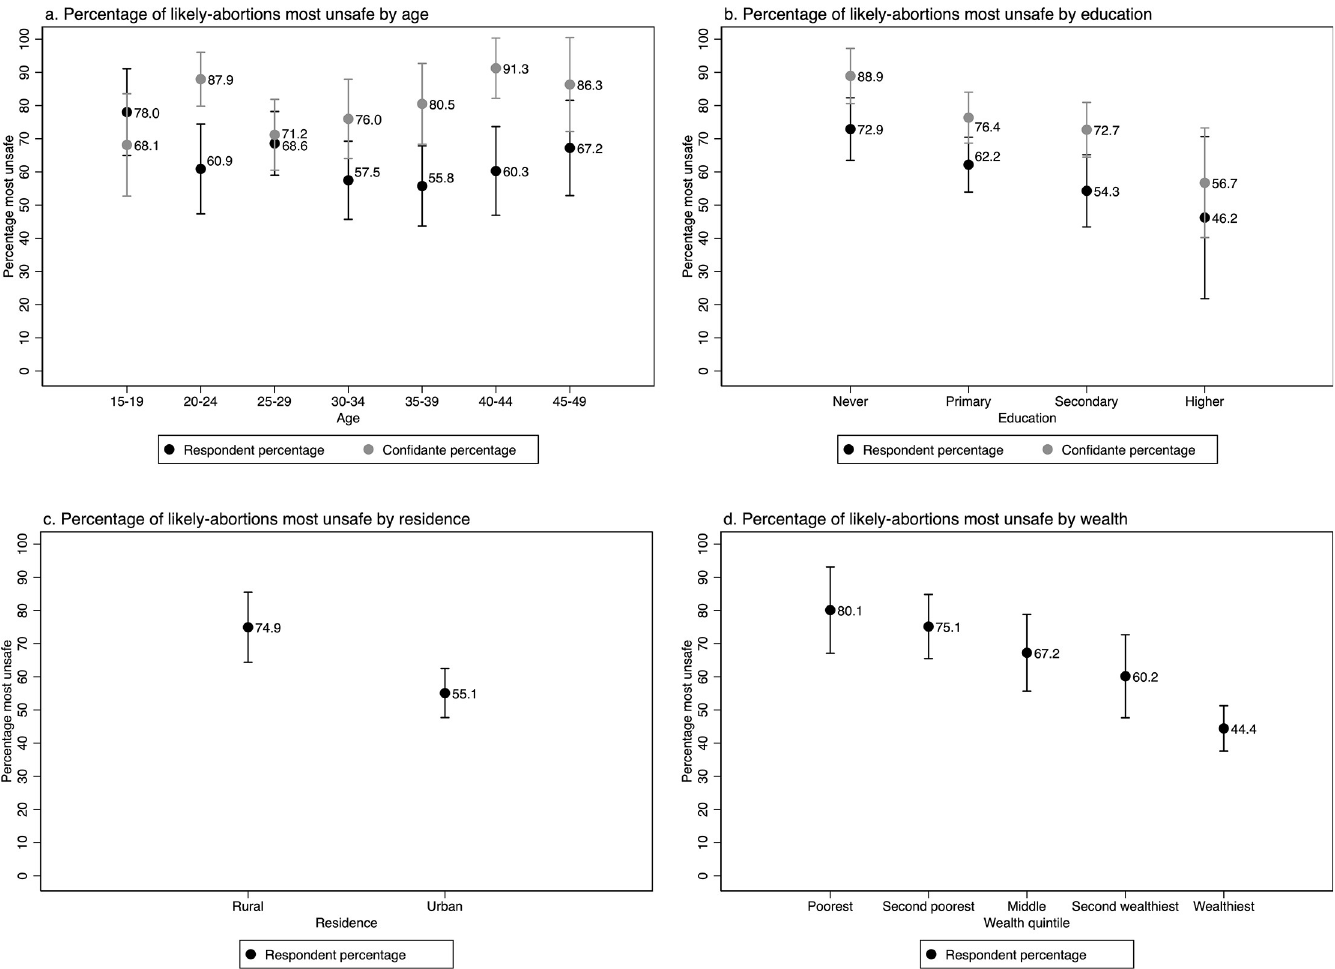
Fig 2. Percentage of most recent likely-abortion among female respondents and their closest female confidantes in Coˆte d’Ivoire that were the most unsafe by background